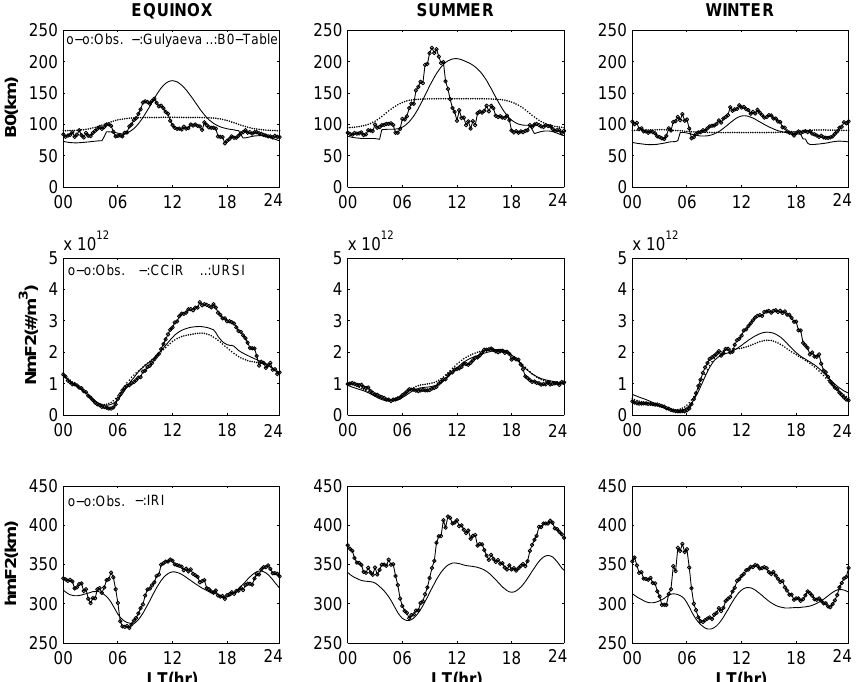
Fig. 3. Diurnal and seasonal variations in B0, Nm F2, and hm F2 measured from the ionosonde (circle) and IRI-2007 (solid and dotted) for the three seasons during